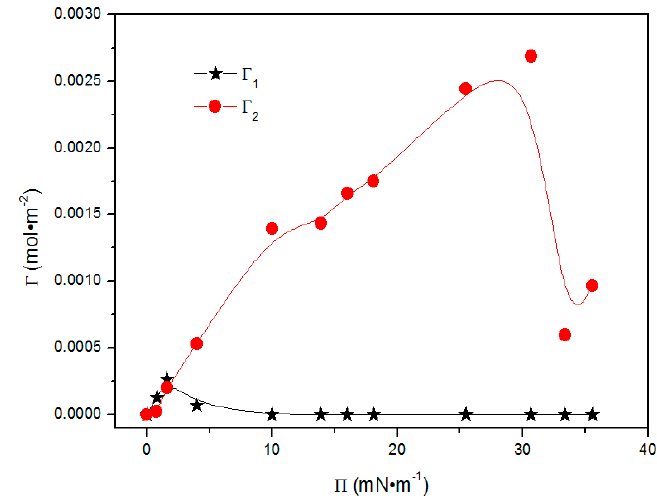
Figure 5. Dependence of the adsorption amount in state 1 and state 2 as a function of surface pressure for mPEG-maleic rosin copolymer.